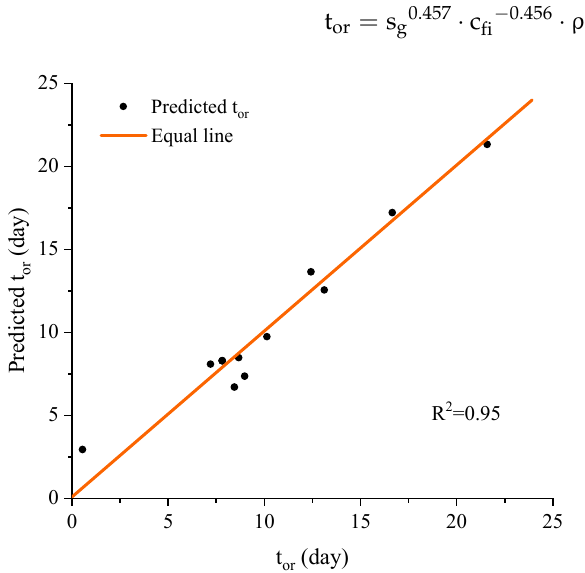
Figure 9. Comparations of tor and the predicted tor through Equation (53).